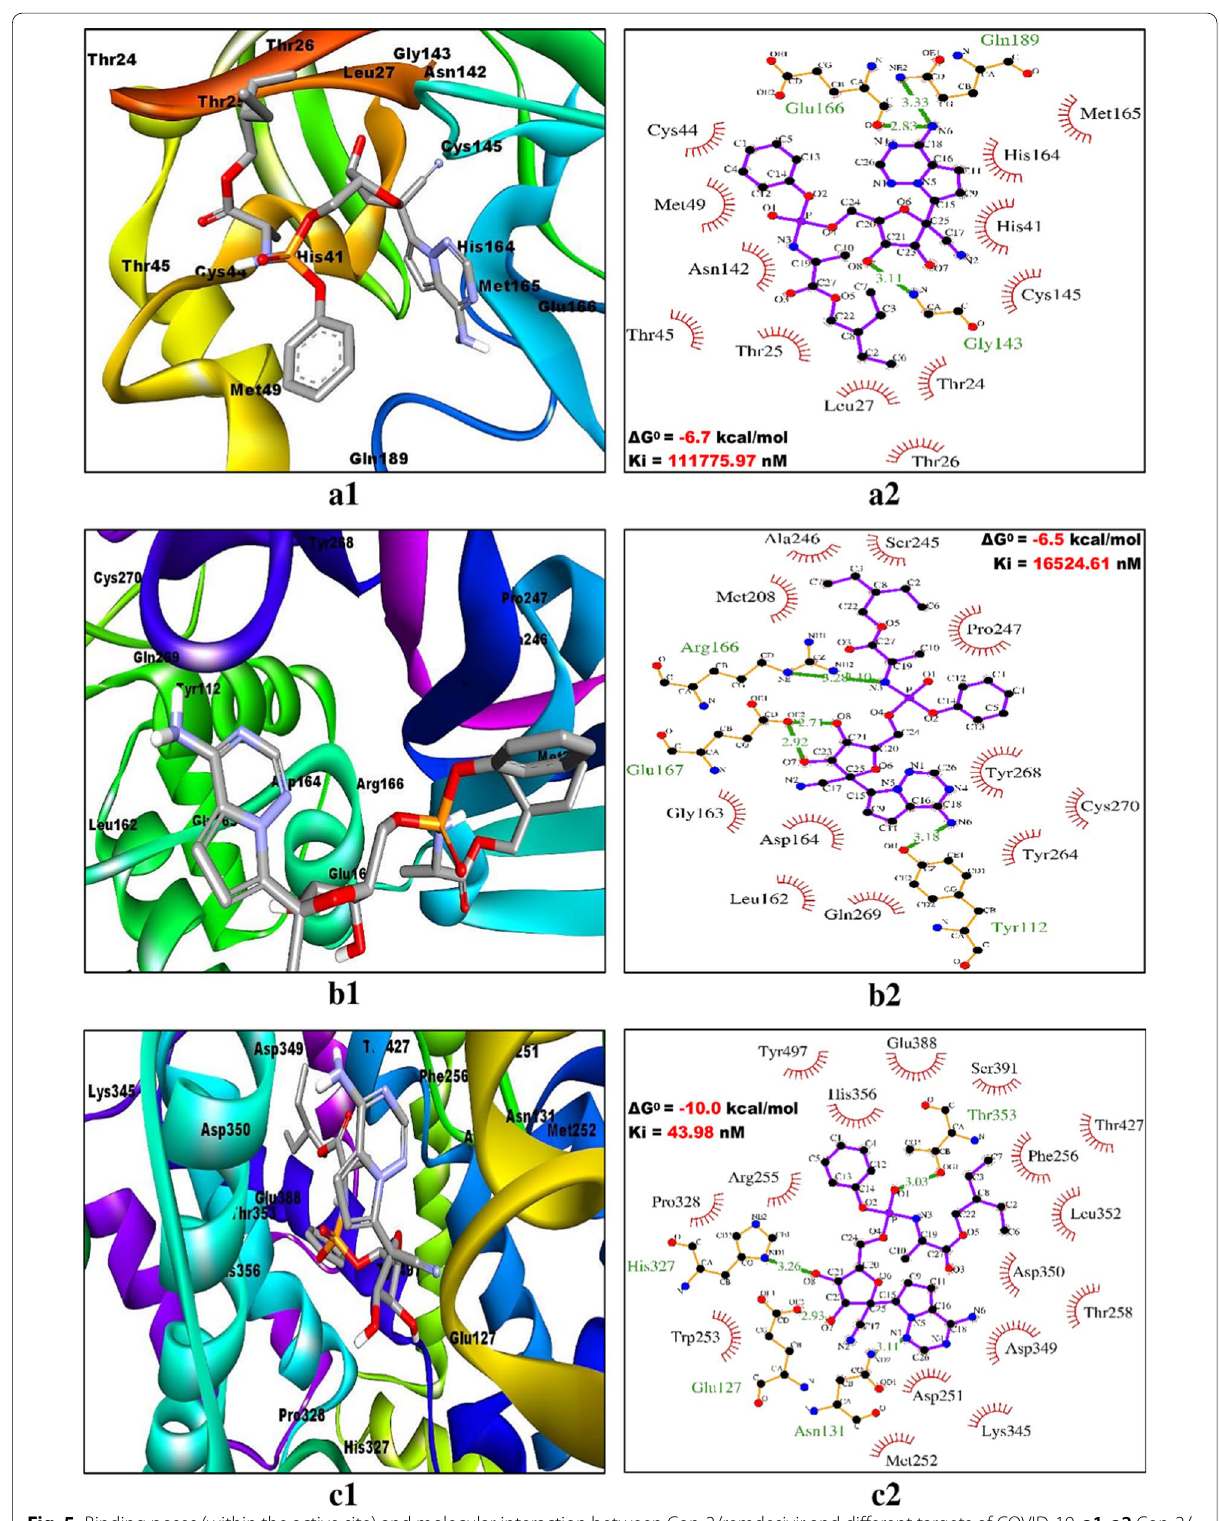
Fig. 5 Binding poses (within the active site) and molecular interaction between Con-2/remdesivir and different targets of COVID-19. a1 , a2 Con-2/ remdesivir and Mpro/3CLpro, b1 , b2 Con-2/remdesivir and PLpro and c1 , c2 Con-2/remdesivir and ACE2. Inside the active site, targets are illustrated as solid ribbon and the bound ligands as stick. The molecular interactions are represented by the green dashed lines for hydrogen bonds and semi-arcs with red eyelashes for hydrophobic